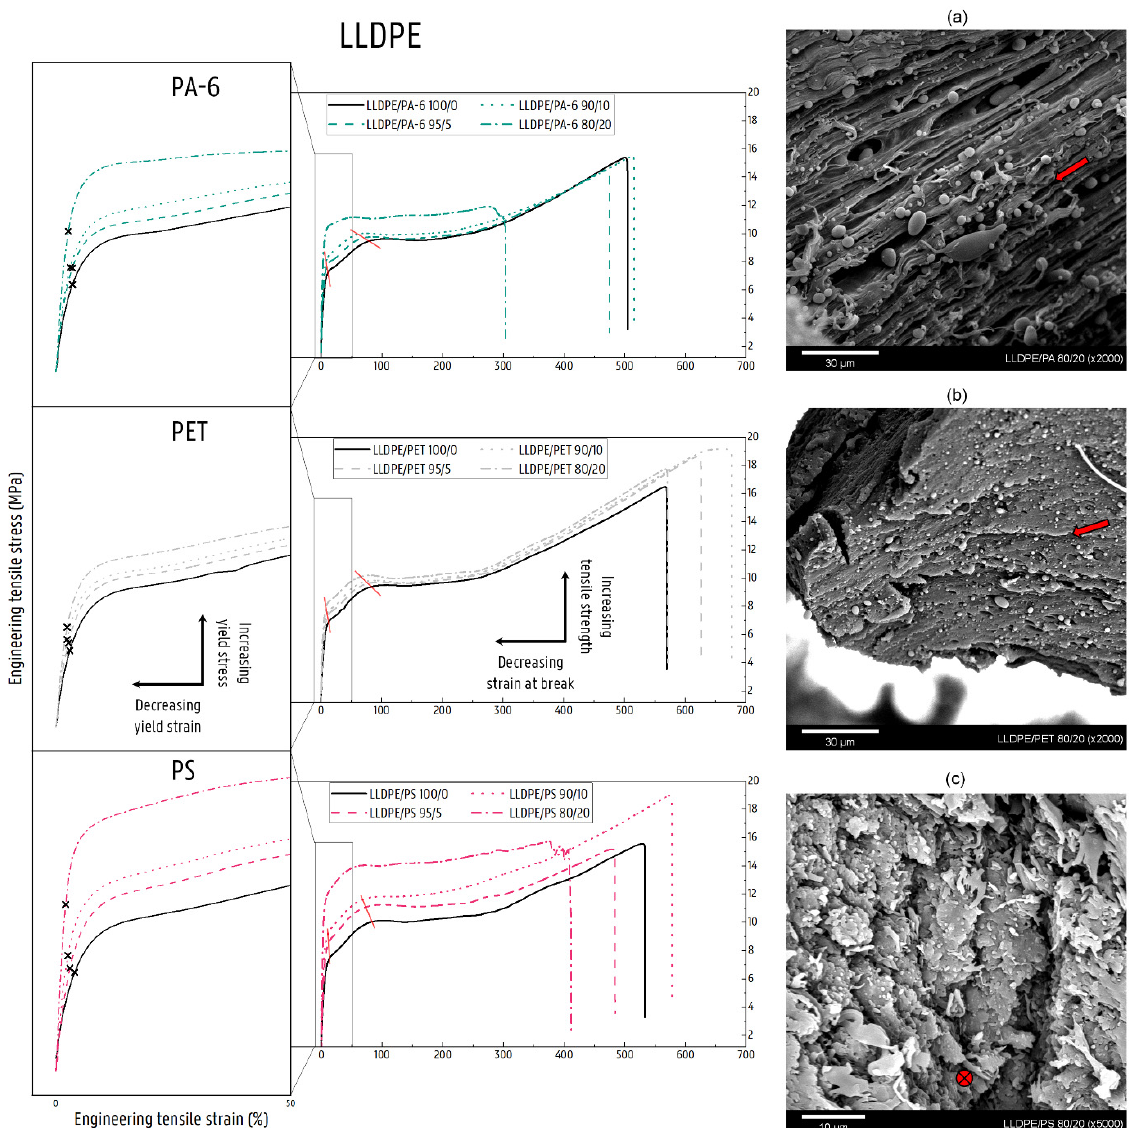
Figure 8. Stress–strain curves of the NPO-contaminated LLDPE matrices (0, 5, 10, and 20 wt% PA-6, PET, or PS). The × markings on the magnified panels indicate the 0.2% offset yield stress. The red lines indicate the double yield point phenomenon correlated with the occurrence of fine and coarse slip. The scanning electron microscopy (SEM) images show the area of rupture of the tensile-tested (deformed) binary blend specimens: ( a ) LLDPE/PA-6 80/20, ( b ) LLDPE/PET 80/20, ( c ) LLDPE/PS 80/20. The red arrow indicates the polymer flow.